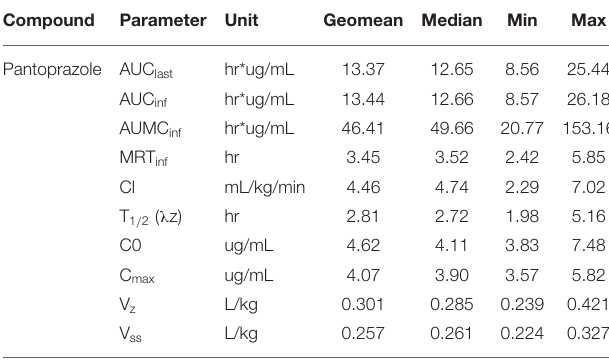
TABLE 1 | Pantoprazole pharmacokinetic parameters following a single intravenous (1 mg/kg) administration to neonatal Holstein calves. Compound Parameter